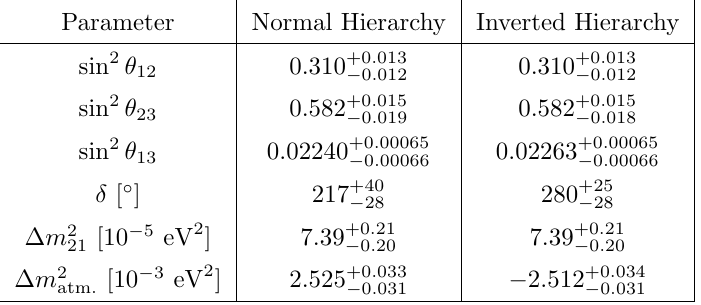
Table 1 . The global (cid:12)t of neutrino oscillation parameters. We use the convention of ref. [54], i.e., (cid:1) m 2 (cid:17) (cid:1) m 2 in Normal Hierarchy case and (cid:1) m 2 atm : 31